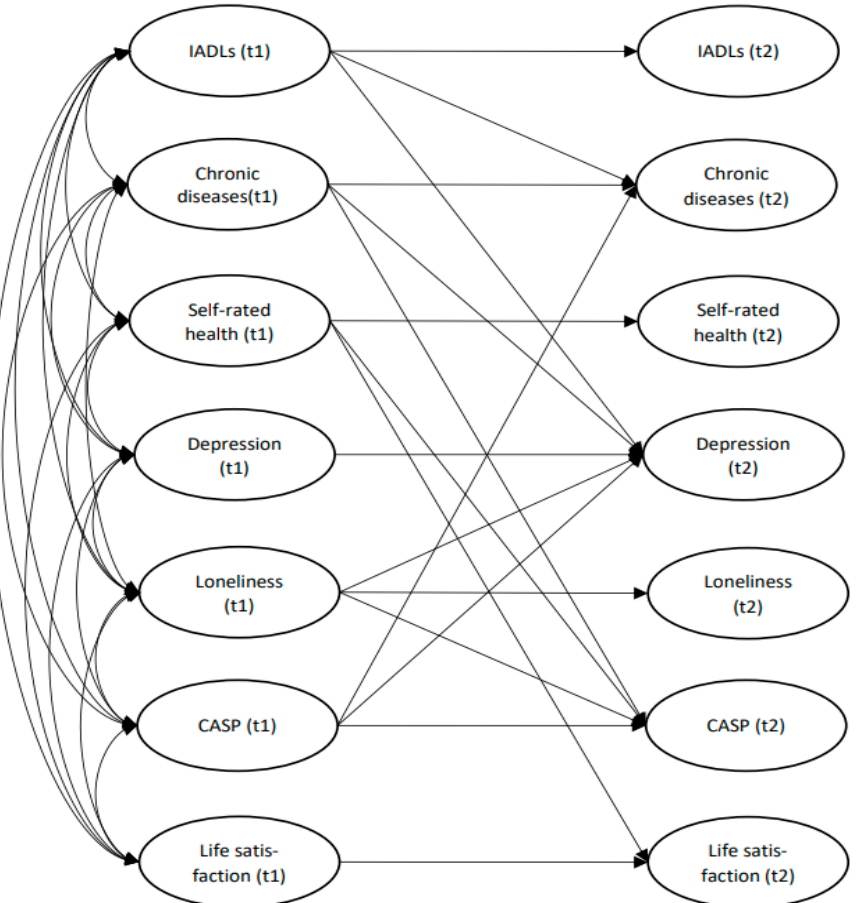
Figure A1. Auto-regressive effect and cross-lagged associations between perceived health, men-tal health, and subjective well-being (Time 1 and Time 2) among older adults with Parkinson’s disease.